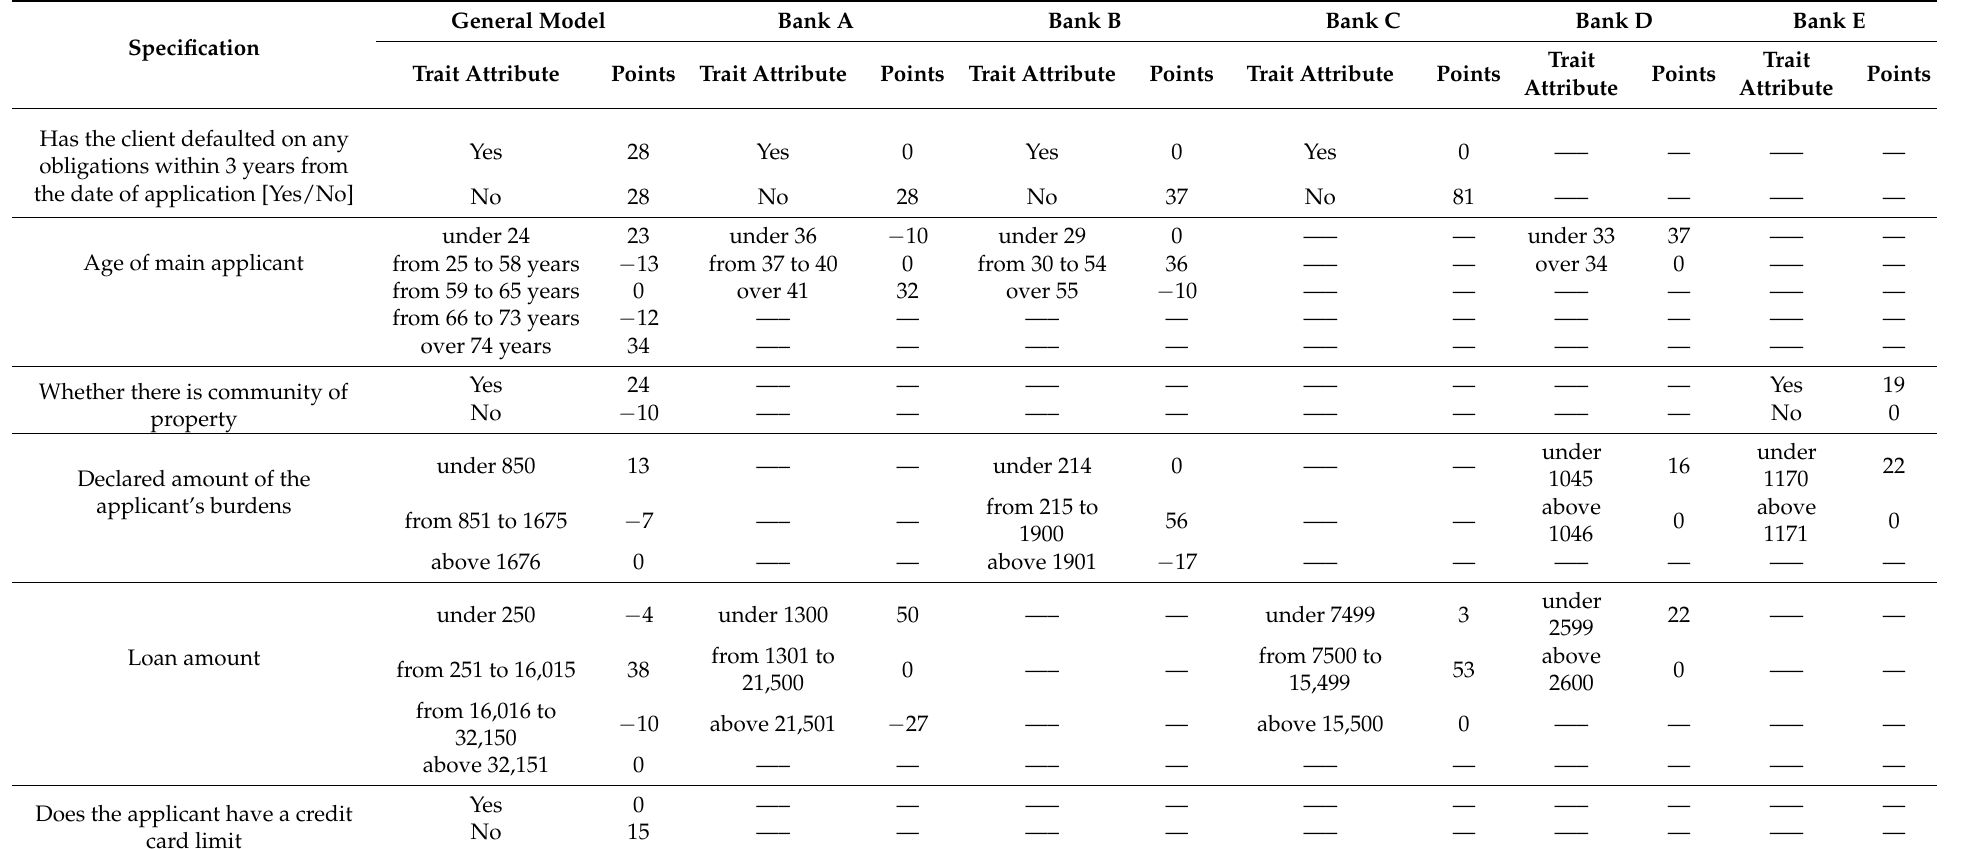
Table 11. Scoring cards for the studied cooperative